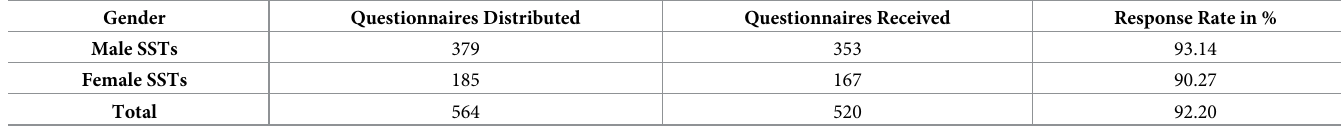
Table 2. Detail of participants’ response